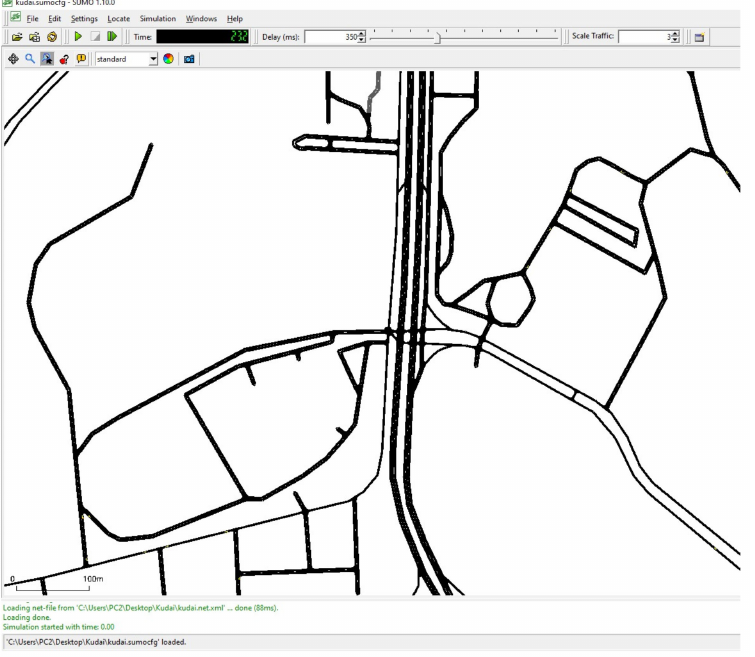
Figure 8. Kudai parking lot in SUMO simulator.